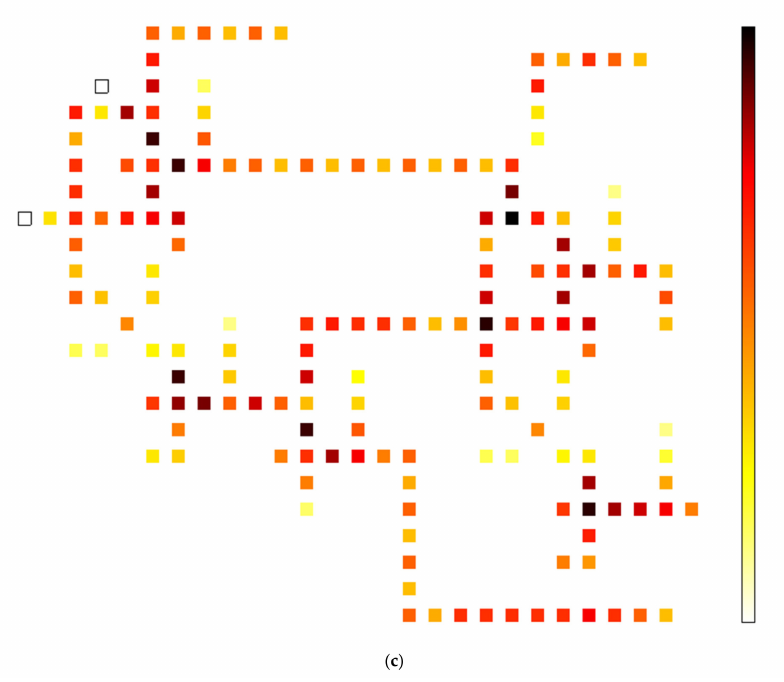
Figure 16. Thermal hotspots of the ( a ) FG gate, ( b ) TR gate, and ( c ) reversible 1-bit comparator at 0.5